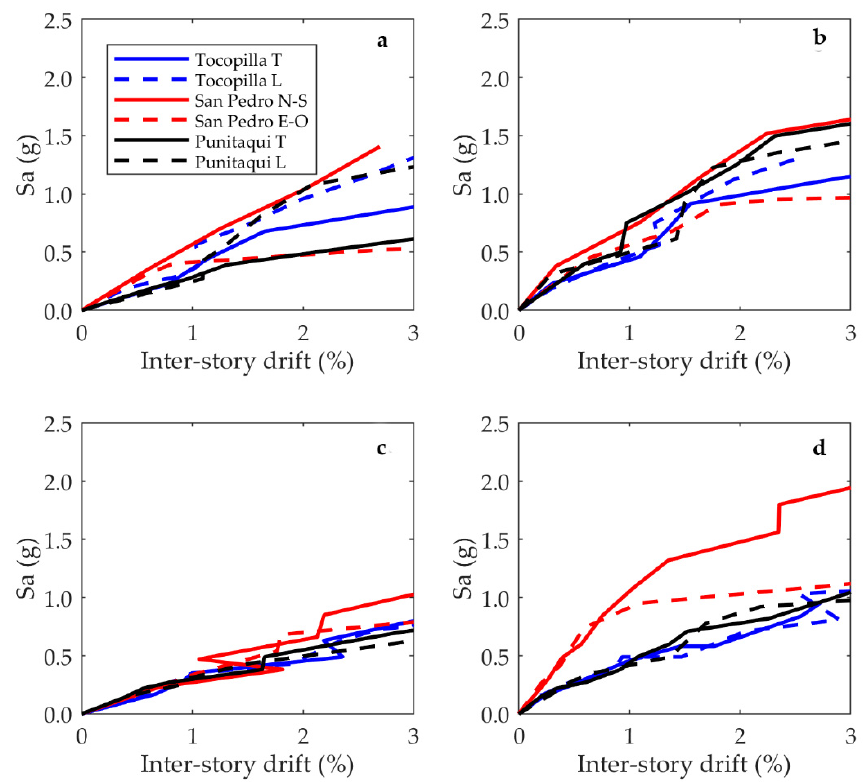
Figure 12. IDA curves for the ductile model M3-D in longitudinal ( a ) and transverse ( b ) directions. IDA curves for the brittle model M3-B in longitudinal ( c ) and transverse ( d ) directions.